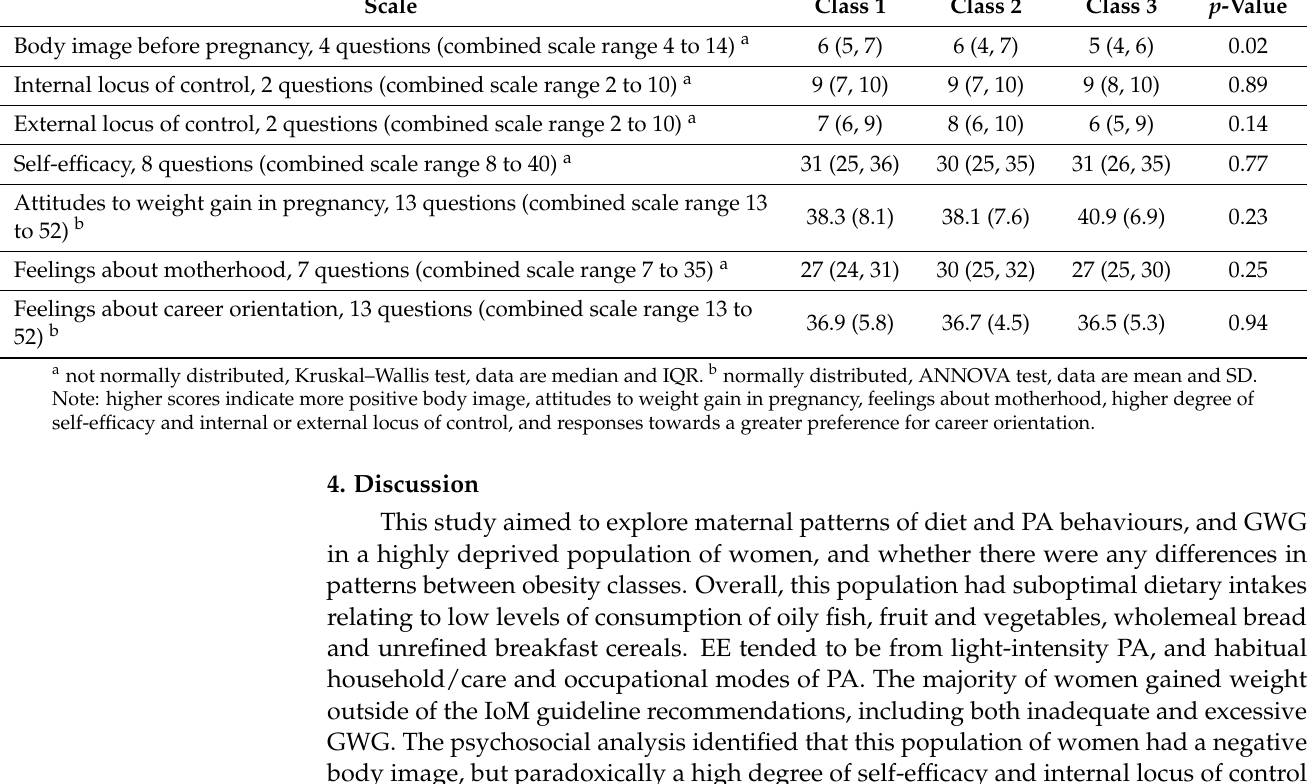
Table 6. Psychosocial measures relating to weight and related behaviours, stratified by obesity class. Scale Class 1 Class 2 Class 3 p